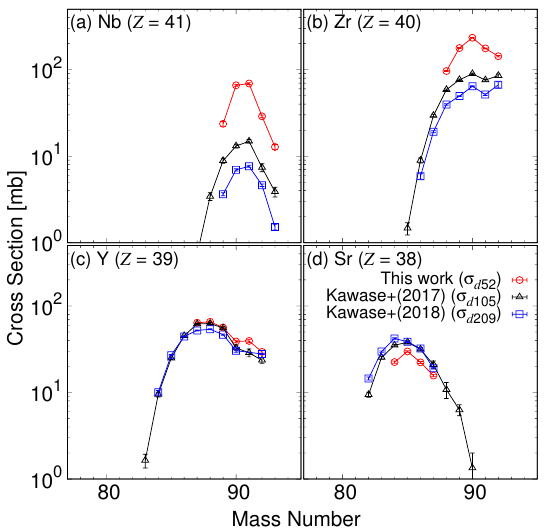
Figure 1. Particle identification plot for the secondary beam. Figure 2. Particle identification plot for reaction products from The red box outlines the 93 Zr beam. the H target after selecting the 93 Zr beam. 2 Figure 3. The measured isotope-production cross sections for p - induced reaction on 93 Zr at 51 MeV with previous works at 105 and 209 MeV.